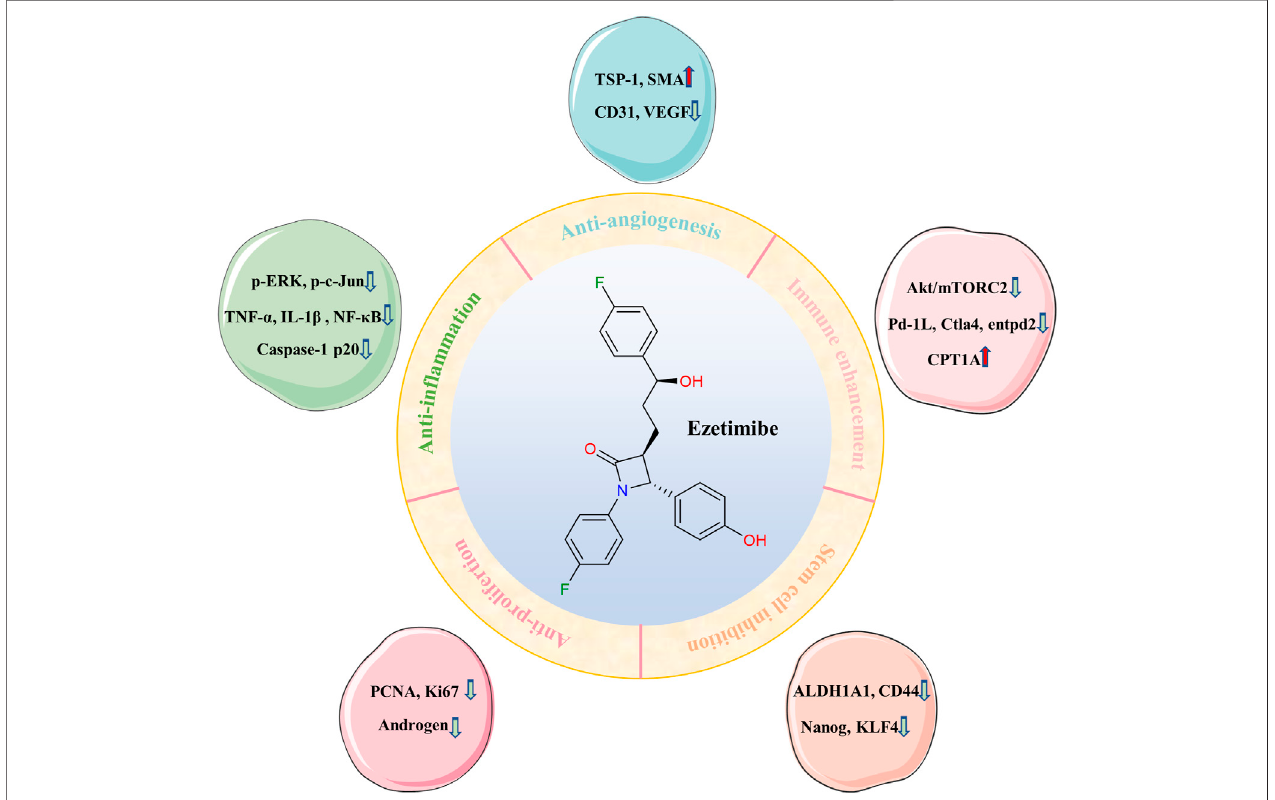
FIGURE 2 | The general map of mechanisms of ezetimibe against